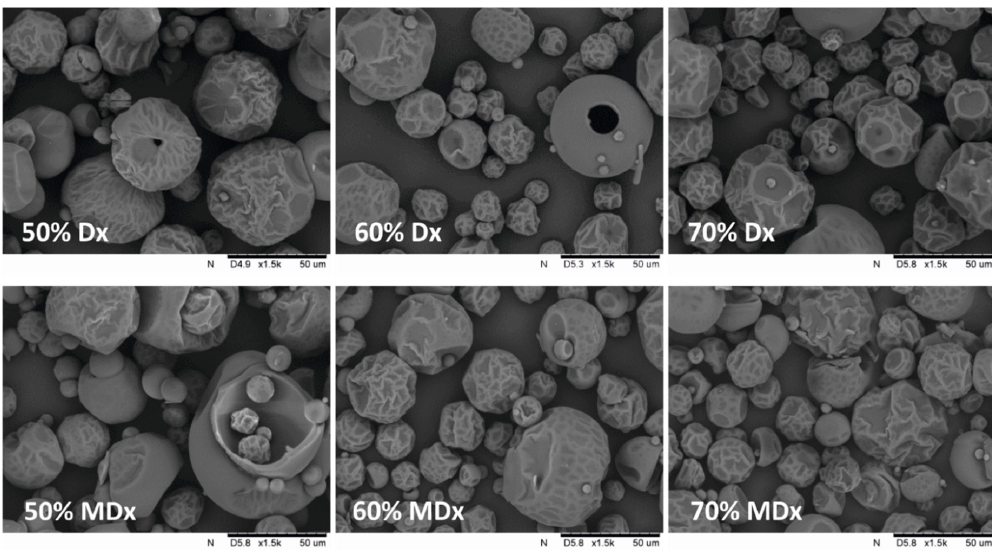
Figure 1. Microscopic images of spray-dried chokeberry juice particles for various types and content of the carrier at 1500x magnifications (Dx—tapioca dextrin, MDx—potato maltodextrin).